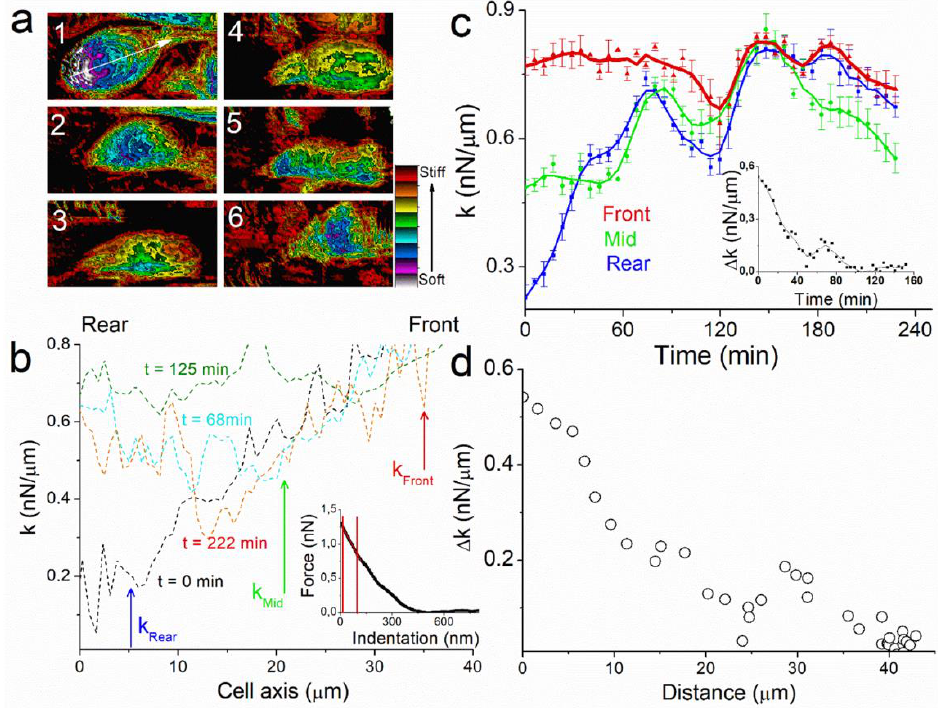
Figure 3. ( a ) Spring constant images of the cell (70 µm × 31 µm) at t = 0, 57, 85, 105, 130, 217 min respectively that show the gradient in k along the cell motion axis (Image 1, white arrow). Z-scale: 1 nN/µm. The spatial resolution used for each image was 128 × 128 pixels, this corresponds to 16,384 indentations performed for each map during cell stiffness characterization. ( b ) Profile of the k-image along the cell motion axis for t = 0, 68, 125, 222 min, respectively. The blue (rear), green (mid), and red (front) arrows indicate the position where k was calculated. The inset represents a force–distance curve performed onto the CRFK cell with the region (red lines) where the spring constant k is calculated. ( c ) Real time plot of the spring constant k measured for three distinct points of the cell along the motion axis at the rear (blue), middle (green), and front (red) respectively, with the evolution of ∆ k rear-front (inset). ( d ) Plot of ∆ k rear-front as function of the cell’s traveled distance. For more clarity, we plotted the temporal evolution of spring constant for three points of the cell axis at the rear, middle, and the front edge of the cell axis (See methods and Figure 3c). As observed with profiles, the value of k rear = 0.23 nN/µm (Figure 3c, blue line) is the lowest at t = 0 min, characterizing the k-dissymmetry along the cell with the value of k front = 0.77 nN/µm (Figure 3c, red line). The first phase of motion (t < 60 min), where the cell moves linearly and its height decreases to 2.4 μm, is characterized b y an